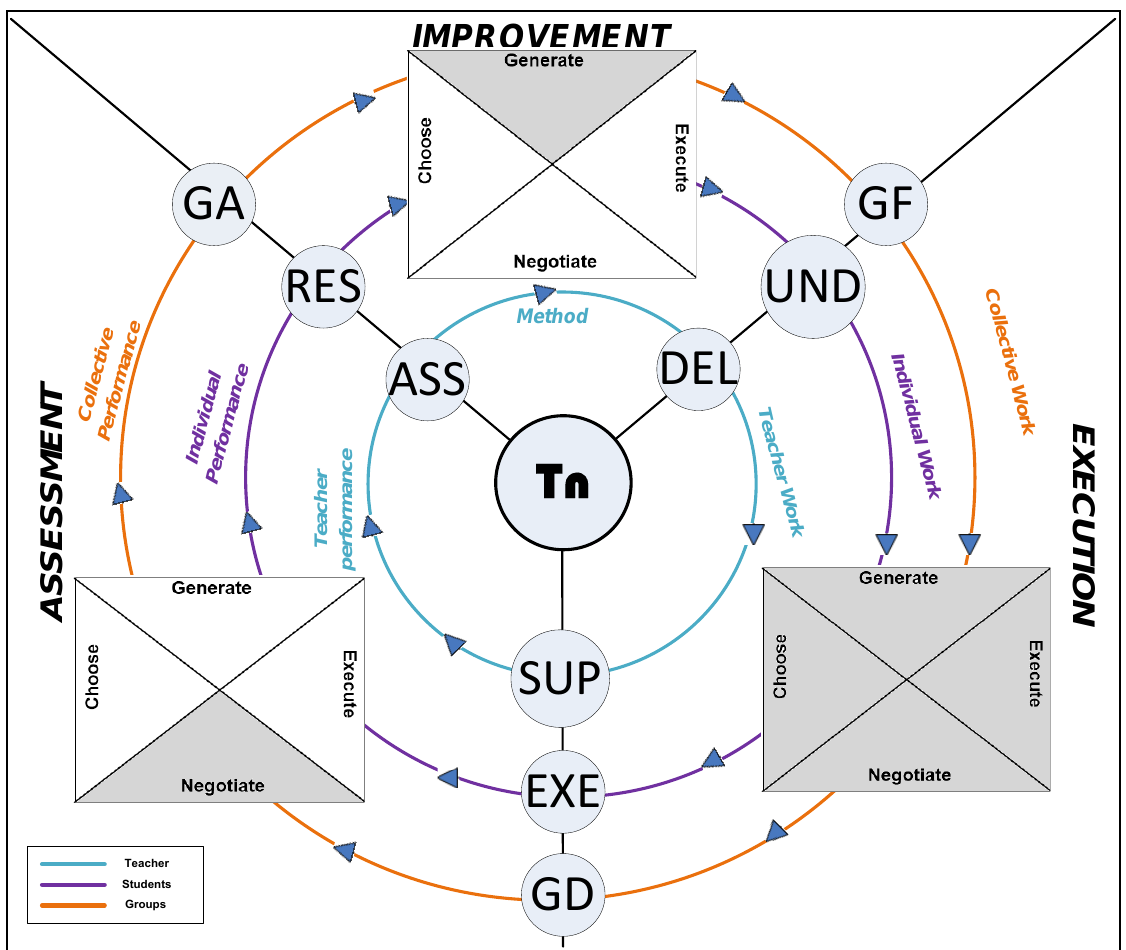
Figure 1 . General view and components of a learning model to promote collective intelligence.